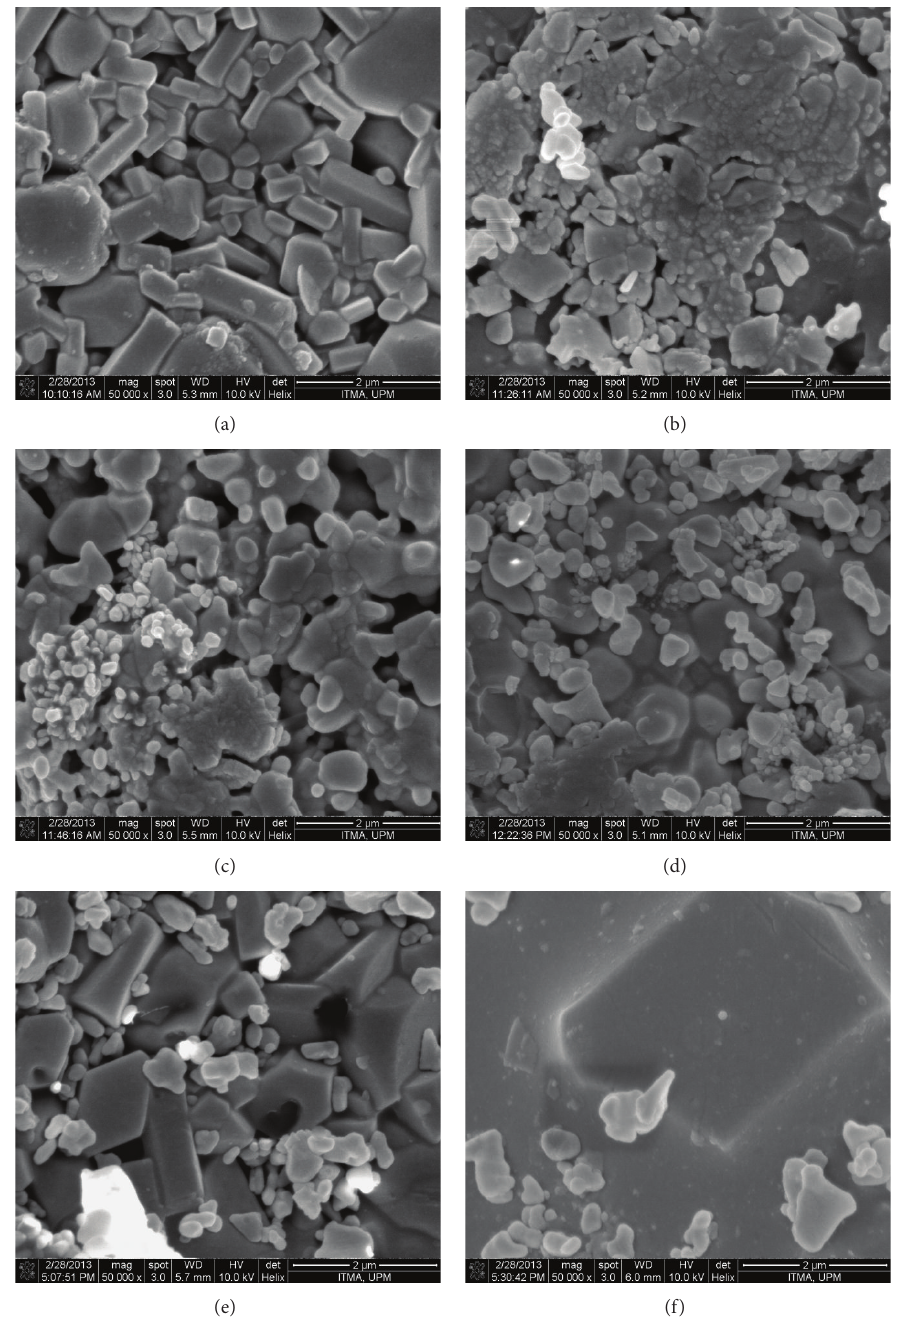
Figure 3: FESEM micrographs of willemite and Er 3+ doped glass-ceramic pellets sintered 4h at different temperatures: (a) willemite, (b) 700 ∘ C, (c) 800 ∘ C, (d) 900 ∘ C, (e) 1000 ∘ C, and (f) 1100 ∘